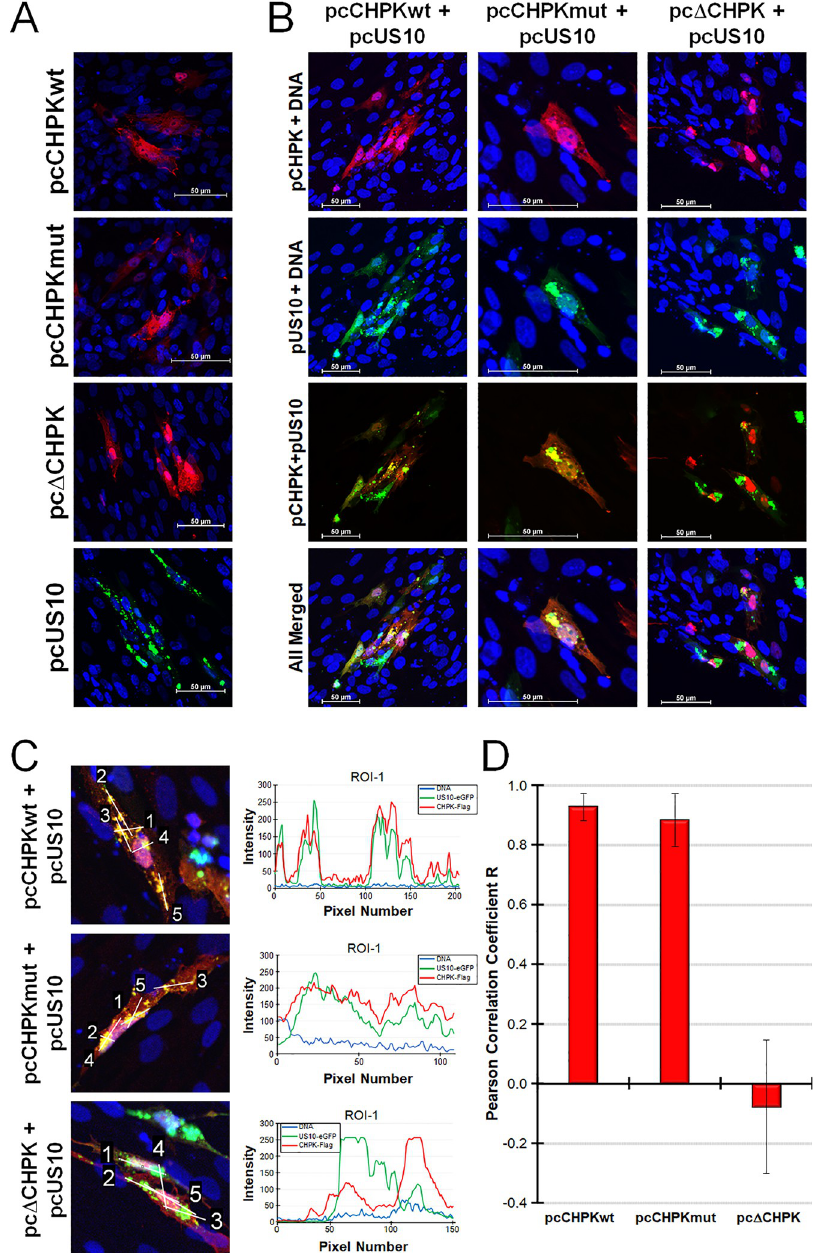
Fig 4. pCHPK and pUS10 colocalize in cells. (A) CECs were transfected with pcCHPKwt, pcCHPKmut, pc Δ CHPK, or pcUS10eGFP and 24 h, fixed and probed with anti-Flag antibody to detect pCHPK or visualized directly for pUS10eGFP. Images of 10–15 z-sections were compiled into a single image using Adobe Photoshop. (B) CECs were co-transfected with pcCHPK expression constructs plus pcUS10eGFP and fixed 24 h later and probed with anti-Flag antibody. Images of 10–15 z-sections were compiled into a single image using Adobe Photoshop. (C) Representative images of single z-sections with linear ROIs labeled and the profile plots for ROI-1 (to the right of each image) were used for quantitative analysis of colocalization. (D) Graphical presentation of the mean Pearson Correlation Coefficient R between pcUS10eGFP and the pcCHPK derivates. Scale bars are 50 μ m.